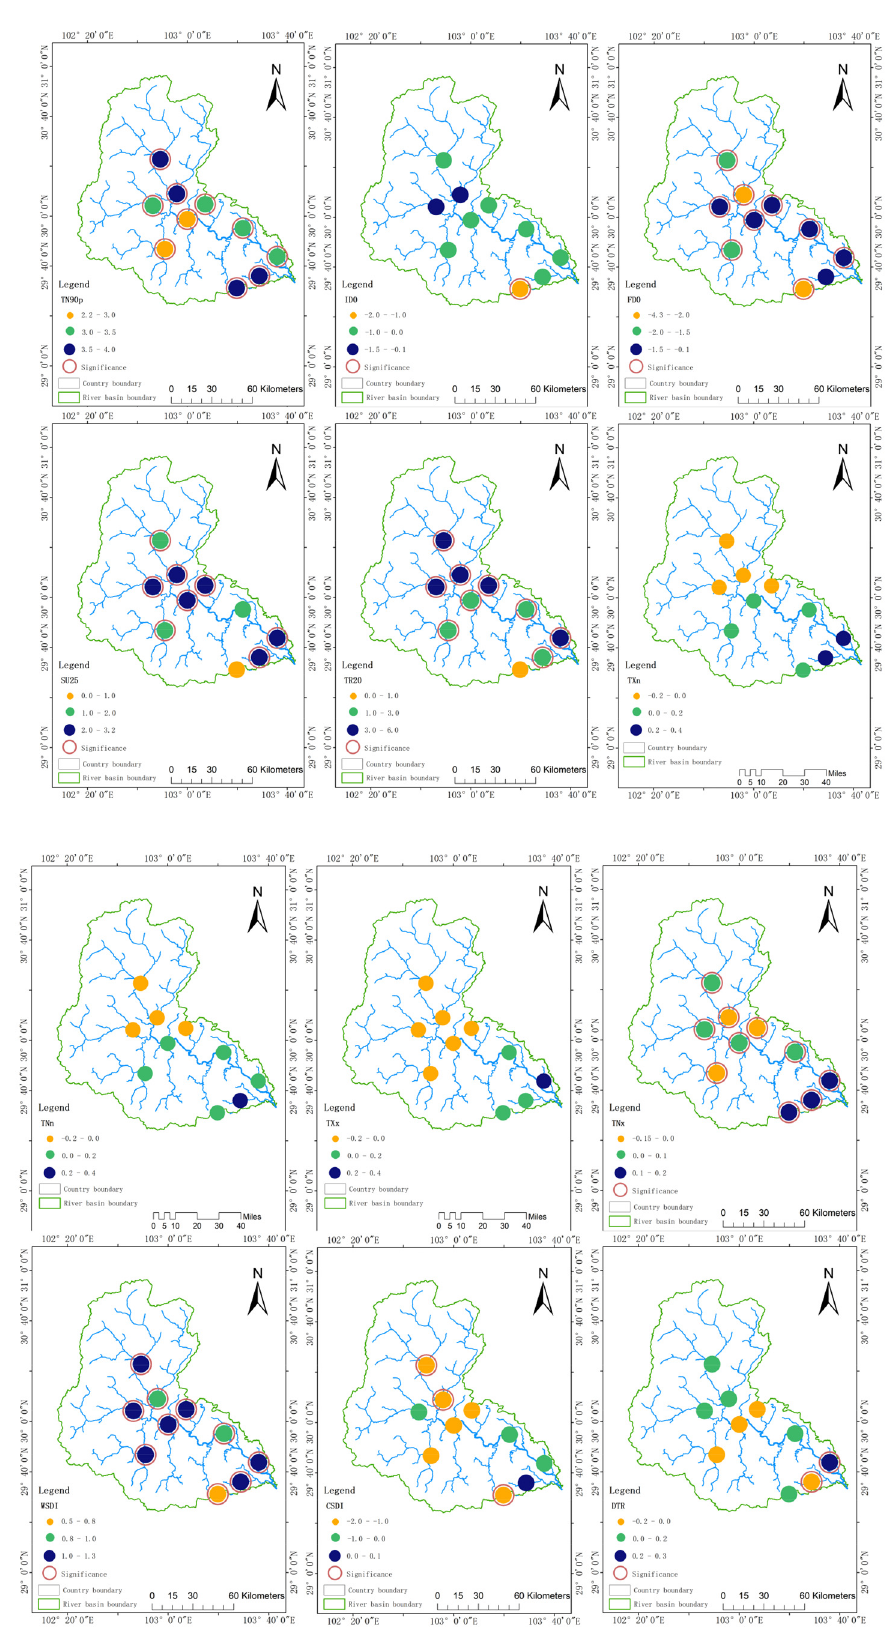
Figure 4. Spatial distribution of the extreme temperature variation trend in the Qingyi River basin from 1960 to 2020 .